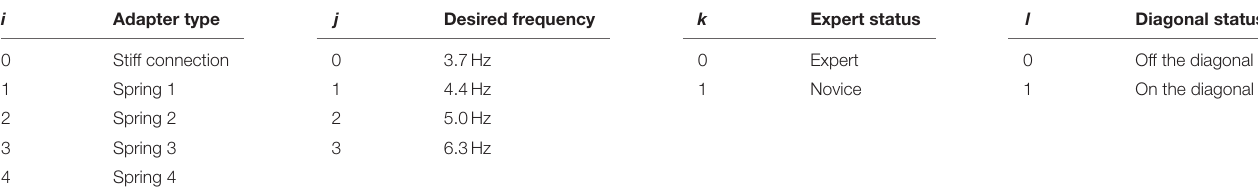
TABLE 1 | Levels of the factors of the mixed model in Equation (7).